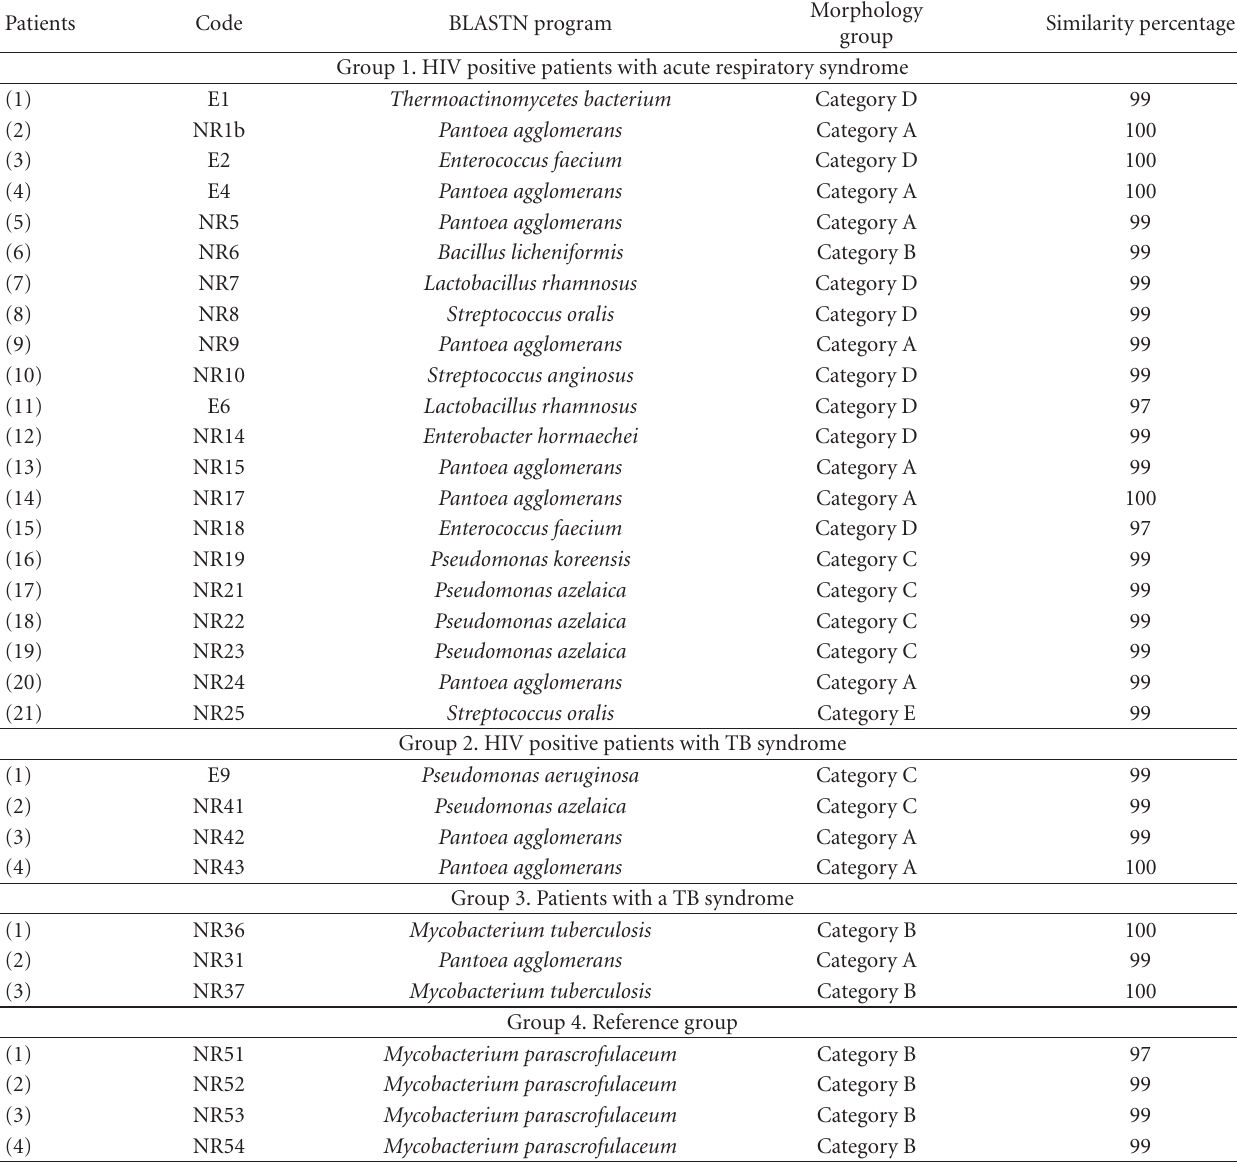
Table 2: Sequenced identified bacteria and the similarity percentage calculated with the BLASTN program. Patients